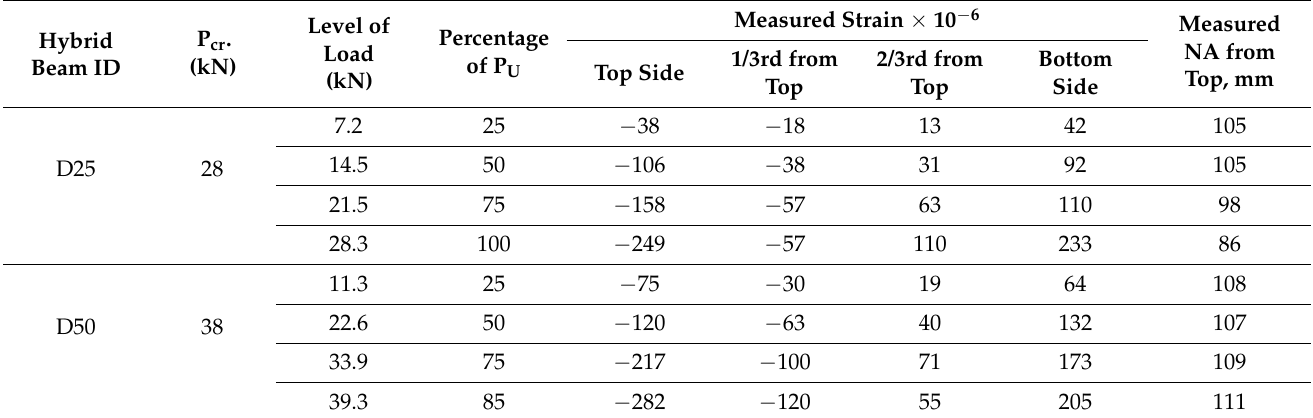
Table 8. Experimental results of load and strain for beams D25 and